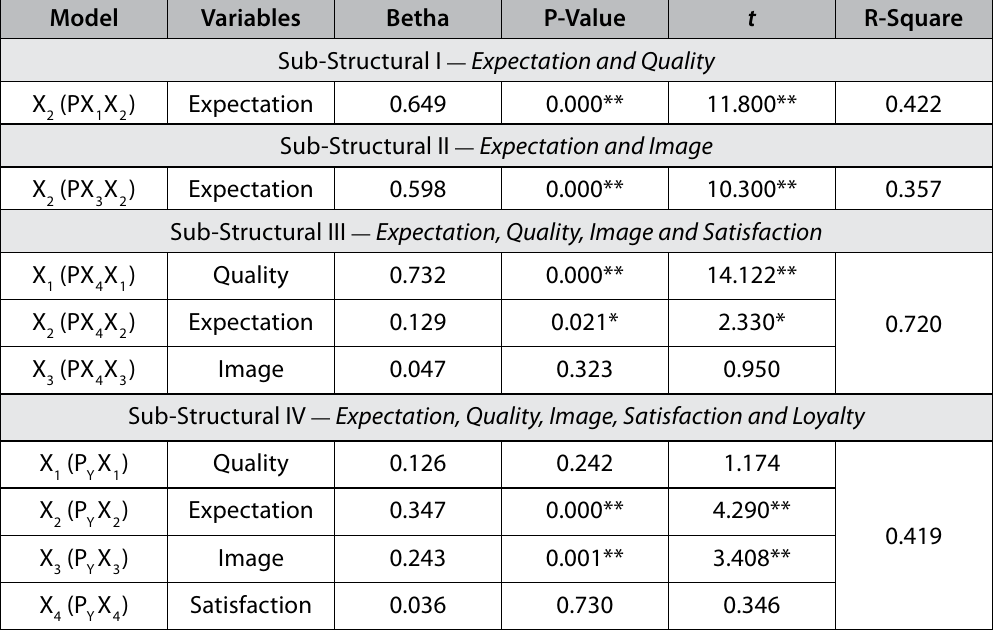
The output after processing all the 193 filled returned questionnaires from respondents, under path analysis approach, is shown in Table 4 . The first table statistically constitutes a non-specific result, prior to modification.